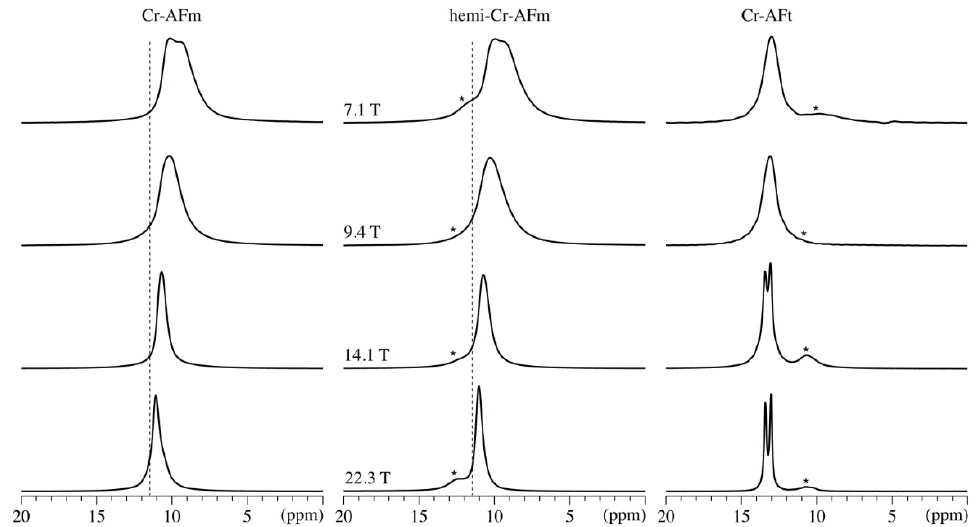
Figure 2. 27 Al MAS NMR spectra of the monochromate (Cr-AFm), hemichromate (hemi-Cr-AFm), and chromate AFt (Cr-AFt) samples, illustrating the central transition regions at 7.1 T ( ν R = 10.0 kHz), 9.4 T ( ν R = 10.0 kHz), 14.1 T ( ν R = 13.0 kHz), and 22.3 T ( ν R = 25.0 kHz). All spectra were acquired with 1 H decoupling during acquisition. The vertical dash lines show the location of the 27 Al isotropic chemical shifts for Cr-AFm and hemi-Cr-AFm, whereas the asterisks indicate minor resonances from impurity phases (see text).